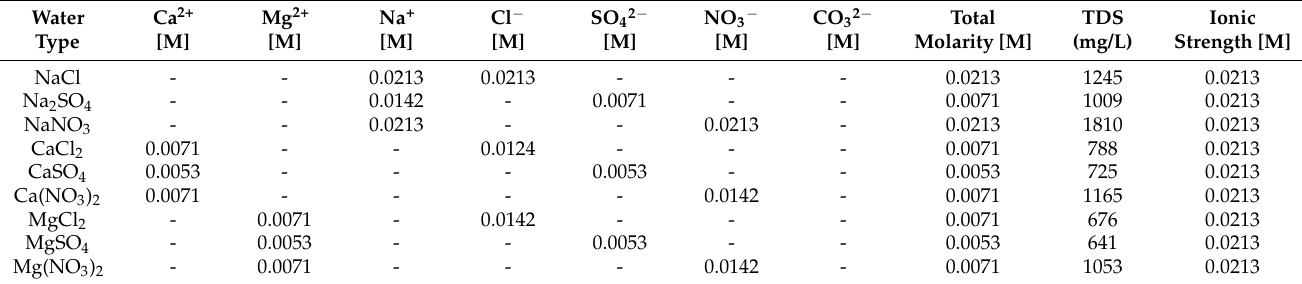
Table 3. Molarity-based composition of the single salts used in this